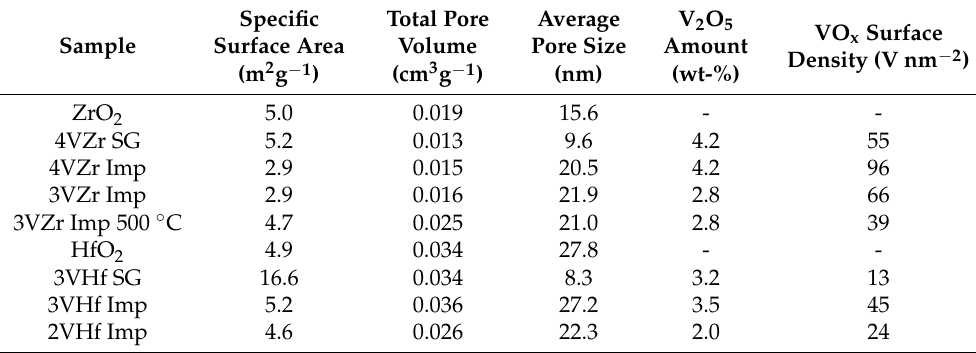
Table 1. Characteristics of the catalysts and supports, including vanadium amount from XRF analysis calculated as V 2 O 5 , and calculated VO x surface densities. The samples were calcined at 600 ◦ C if not indicated otherwise. Total Specific Sample Surface Area (m 2 g − 1 )